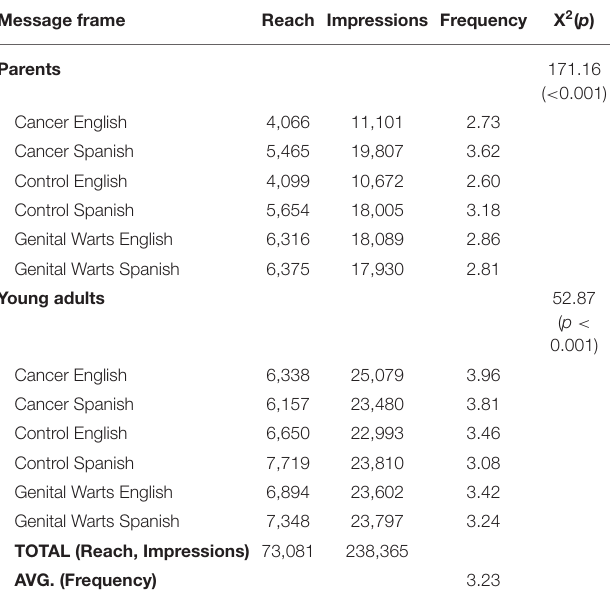
TABLE 1 | Facebook analytics for reach, impressions, and frequency by message frame. Message